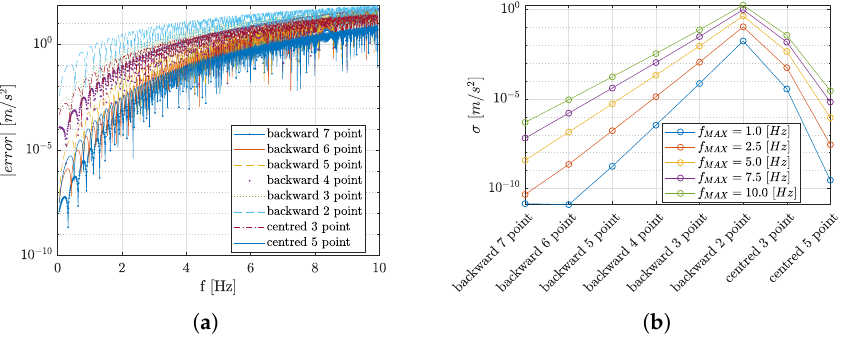
Figure 8. Error estimation of the numerical derivative estimation of Equation (21) at different frequencies. ( a ) Numerical derivative estimation at different frequencies, ( b ) 1 σ error for different